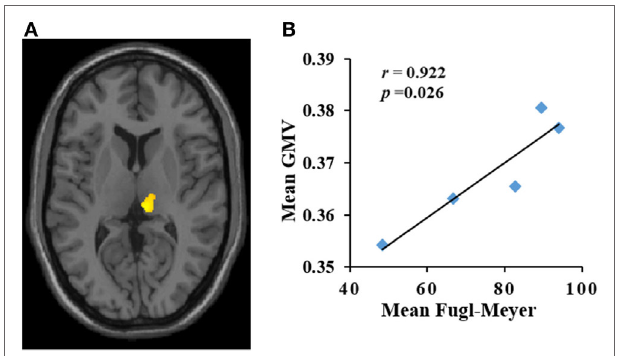
FigUre 2 | (a,B) Increase in gray matter volume (GMV) ( y -axis) in the ipsilateral mediodorsal thalamus was positively correlated with Fugl-Meyer ( x -axis) score in patients with pontine infarction during the period of observation. r indicates Pearson correlation coefficient.